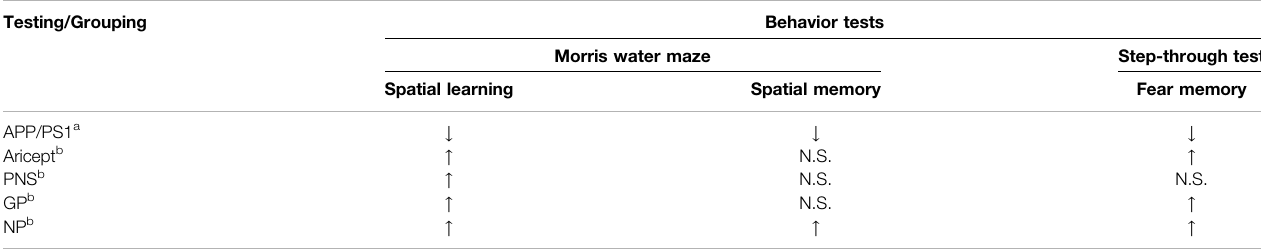
TABLE 2 | Effects on the behavioral